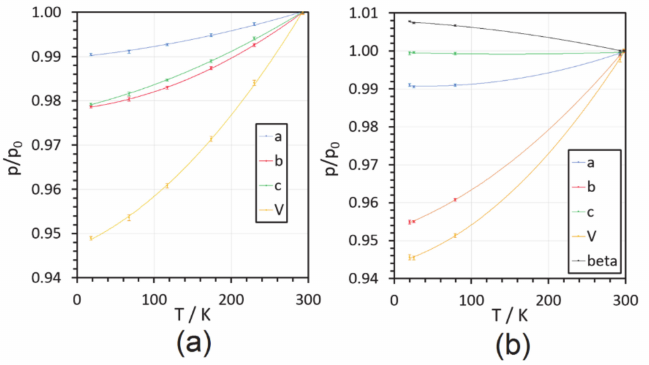
Figure 1. ( a ) Relative changes of lattice parameters ( p = a, b, c, V) of SQ in the T range 18–293 K with respect to room temperature (p 0 ). Vertical bars correspond to 1 estimated standard deviation (esd) and full lines come from linear least squares fittings with 2 nd order polynomials (average R = 0.999). ( b ) Same as ( a ), for SQDH in the range 20–293 K. Average R = 0.999 with the exclusion of c, which does not appreciably change with